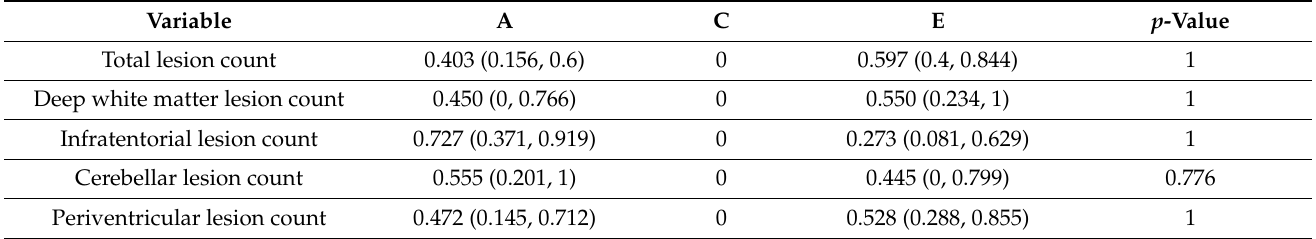
Table 3. Age- and sex-adjusted univariate analysis of the count of WMH in the different brain regions using volBrain in twins. The results were presented together with 95% confidence intervals (95% CI). A stand for heredity, C for shared environmental variation and E for unique environmental